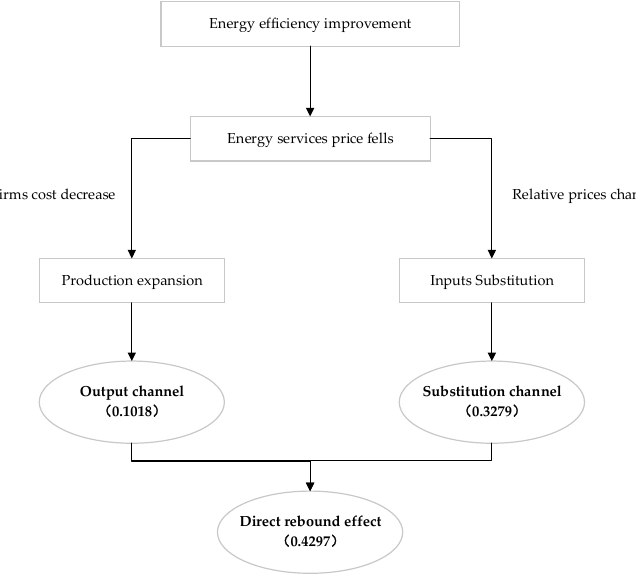
Figure 3. The influence mechanism of the industrial energy rebound effect.